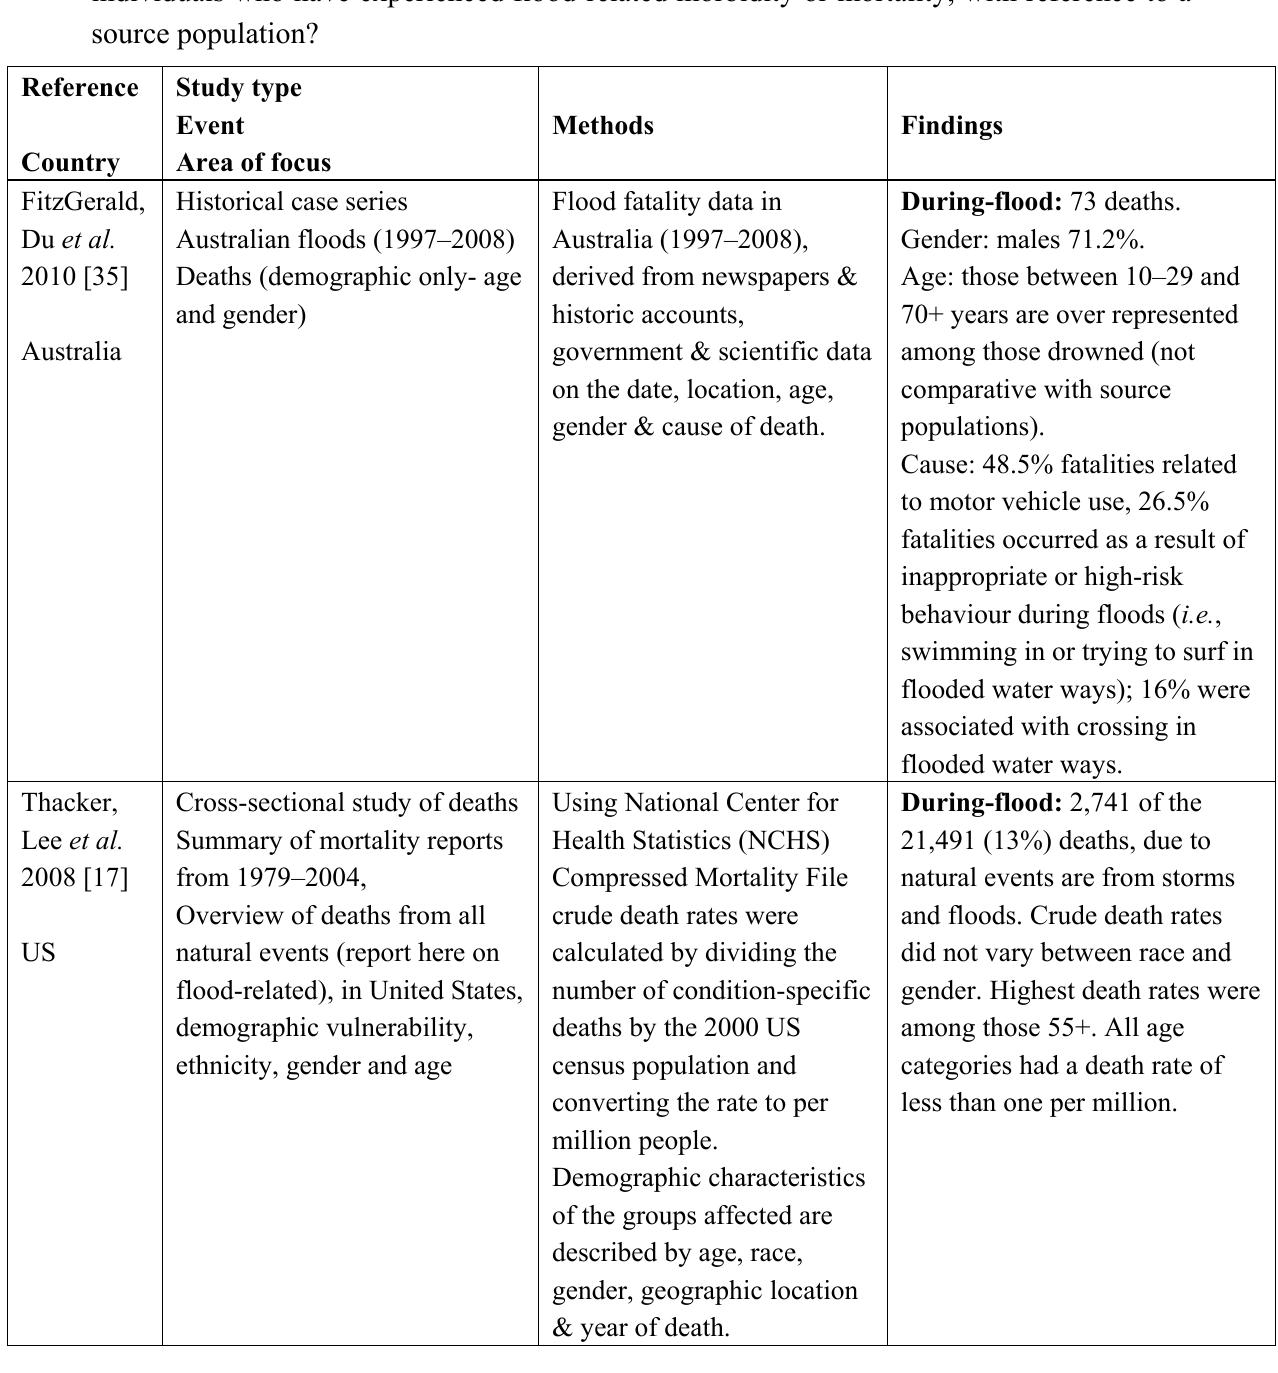
Table A2. Studies addressing research Question 3a: What are the characteristics of individuals who have experienced flood-related morbidity or mortality, with reference to